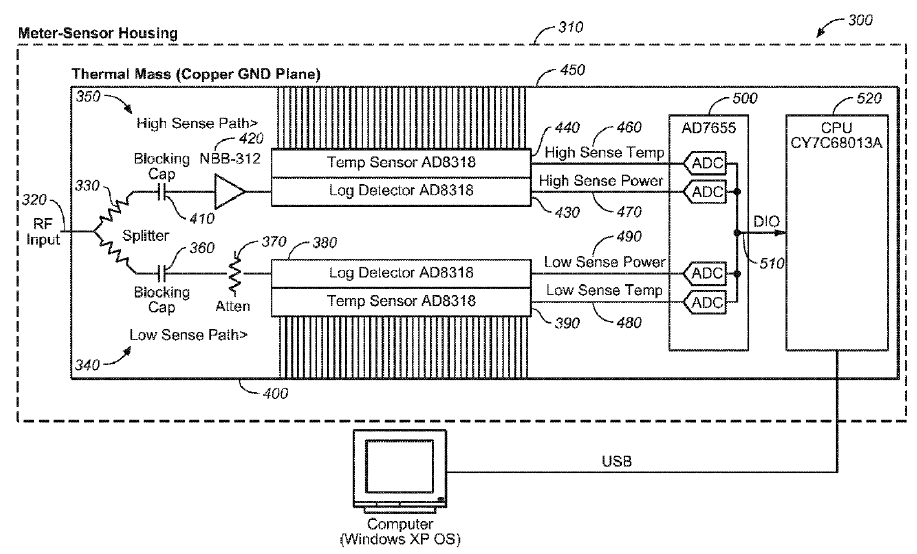
Fig. 3. Block diagram of a LadyBug Technologies power meter.